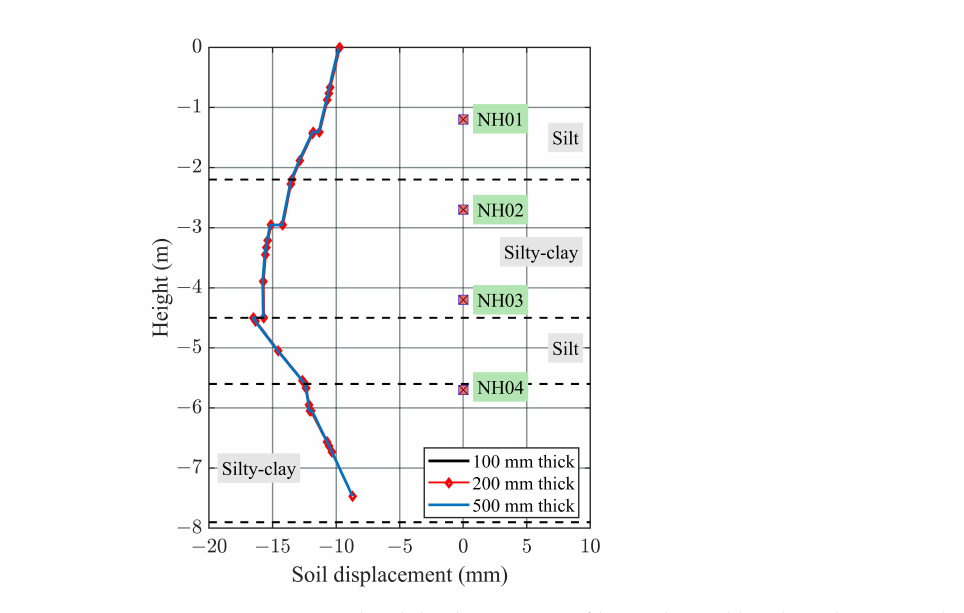
Figure 12. Retained soil displacement profiles under nail heads with various